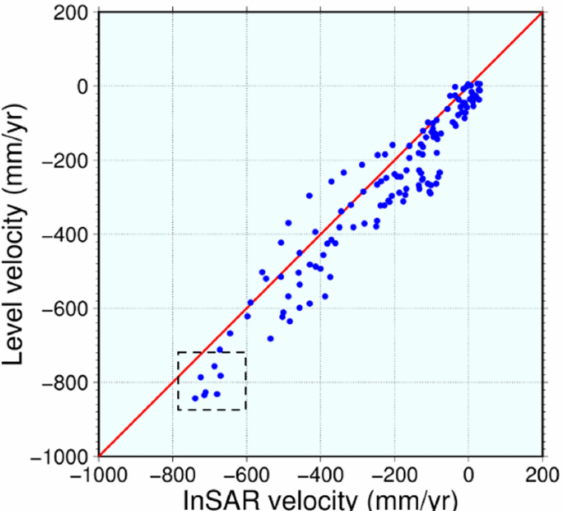
Figure 16. Comparison of the subsidence velocity between the MSBAS-InSAR results and the leveling measurements at the two mining sites of Jiulong and